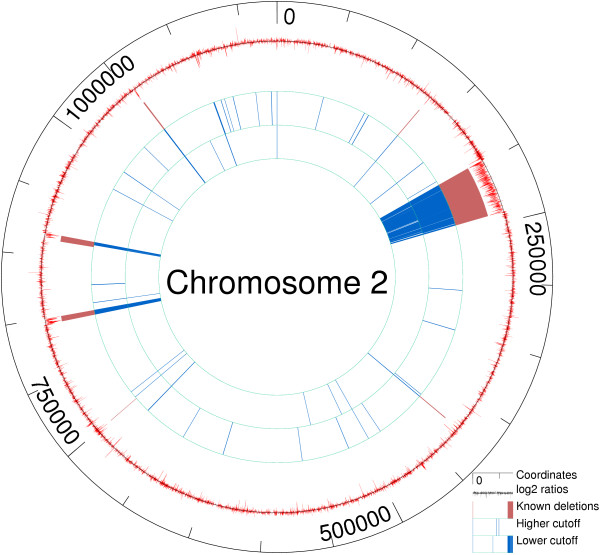
Deletions and variable regions in B. melitensis chromosome II. Regions in red are from Rajashekara et al., (2004). Blue regions are predicted by CGHScan, outer ring using a higher cutoff (which results in lower stringency), and the inner ring with a lower cutoff (which results in higher stringency).